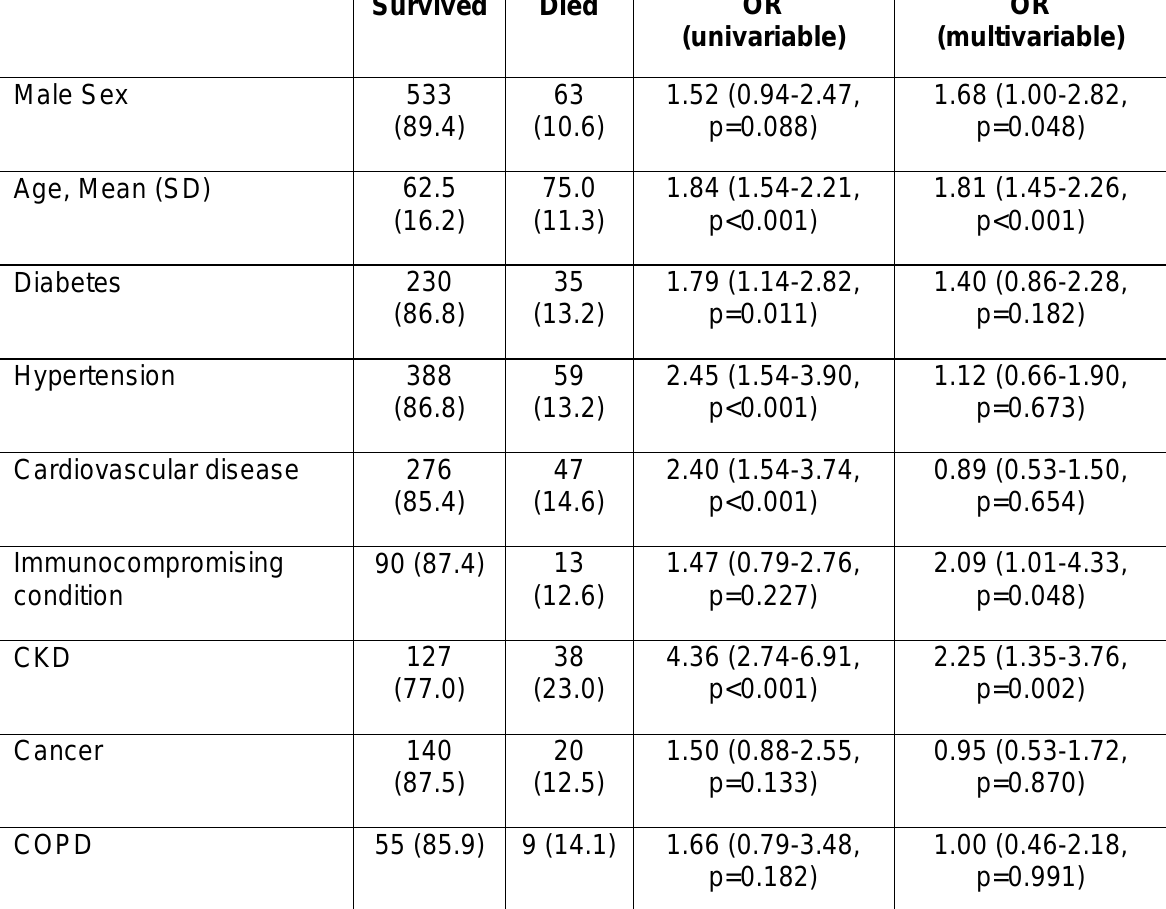
Table S2: Factors associated with Mortality from logistic regression modeling. CKD denotes chronic kidney disease, COPD denotes chronic obstructive pulmonary disease, OR denotes odds ratio and is displayed as OR (95% confidence